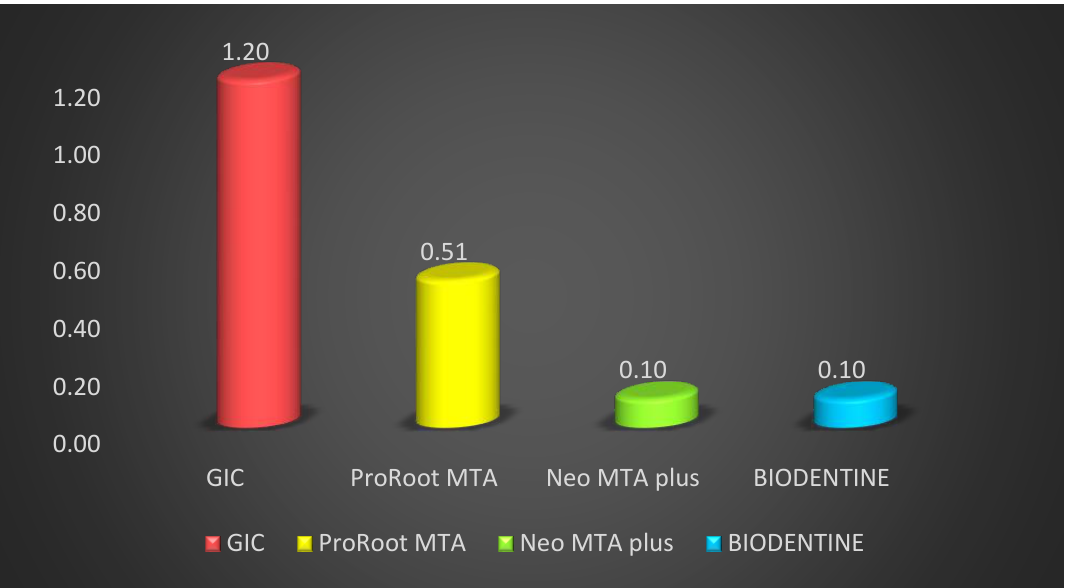
Figure 3. Comparison of the sealing activity of different root end filling material at 15 days. The comparison of microleakage at one month for different groups is shown in Table